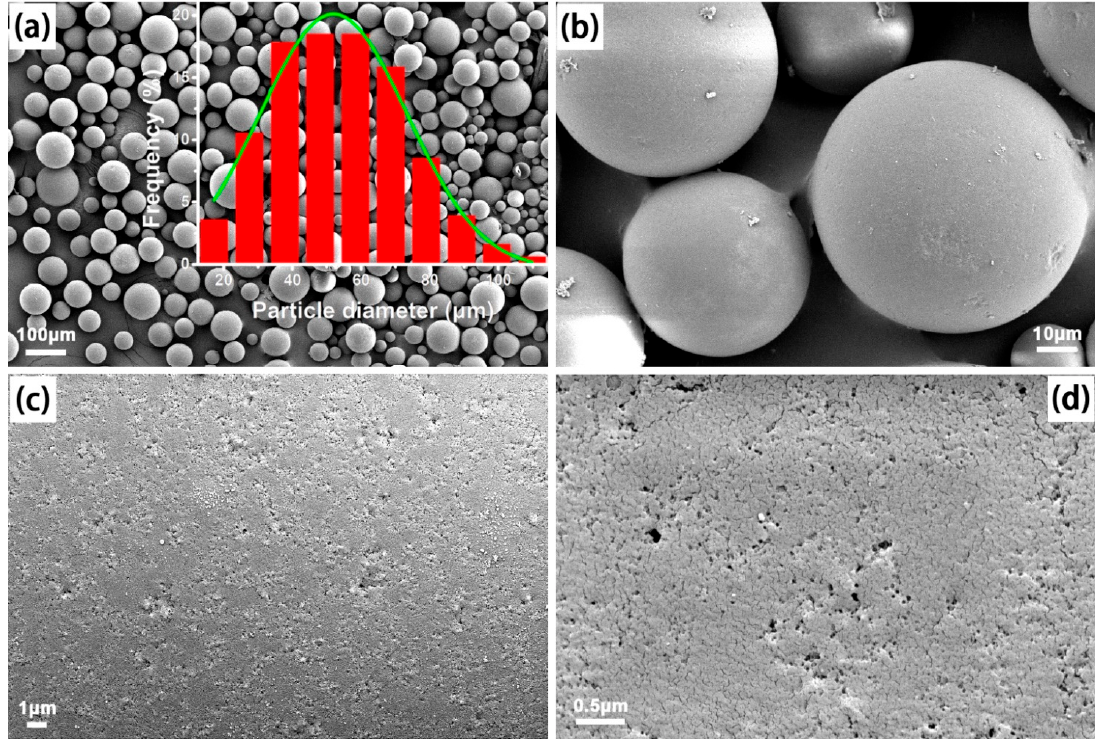
Figure 2. ( a – d ) SEM images of the MIPMs with the molecular imprinting treatment and the inset in ( a ) shows the particle size distribution histogram.